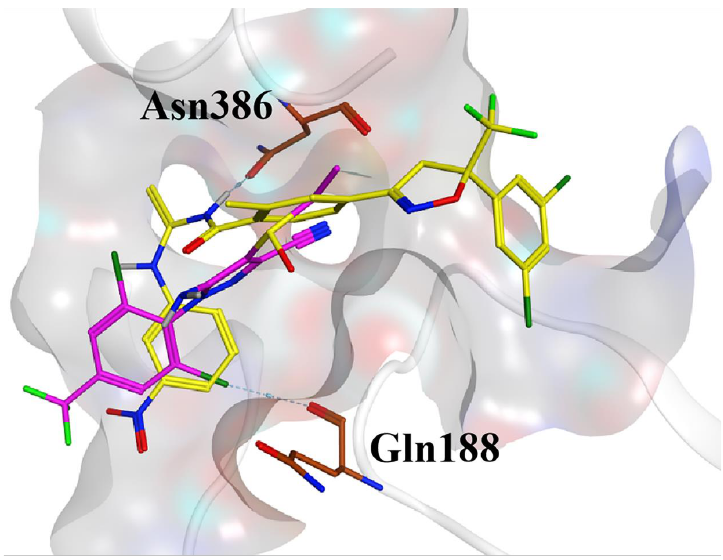
Figure 7. Predicted binding pattern of compound 32 (yellow) and ethiprole (pink) at the GABA- active site.